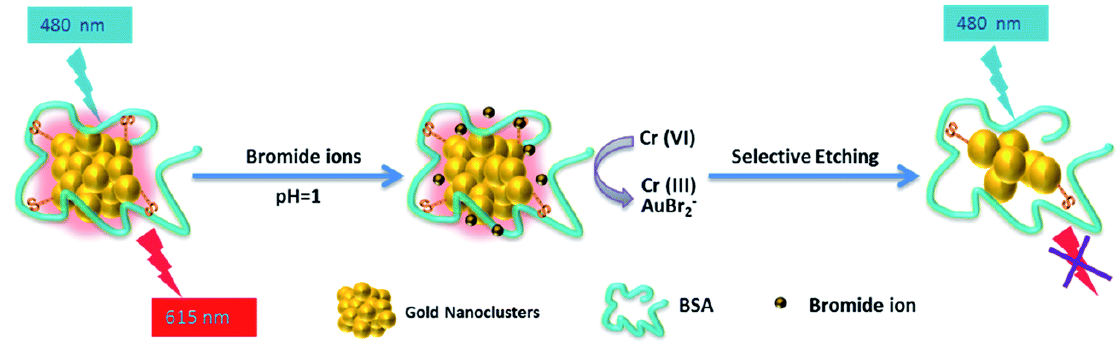
Figure 11. Schematic diagram of synthesis of GSH-Au NCs ( a ) and realization of detection of Cr(III) and Cr(VI) ( b ). Reprinted with permission from Ref. [33]. Copyright © 2013 Elsevier B.V.